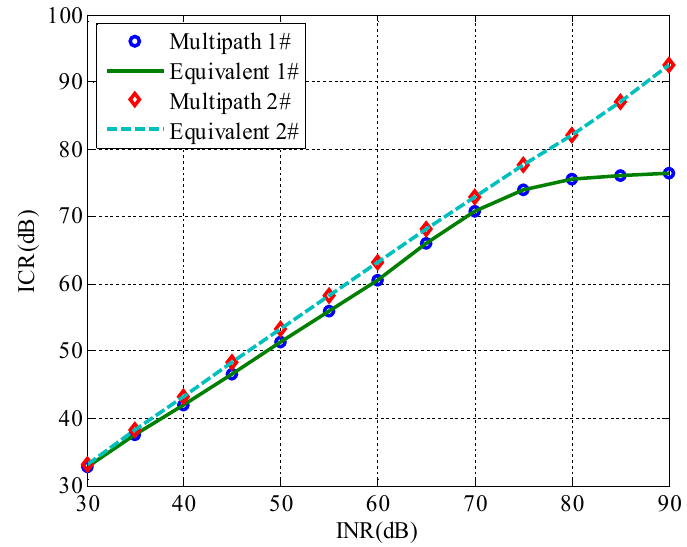
Figure 7. Verification for the equivalent model that used STAP.